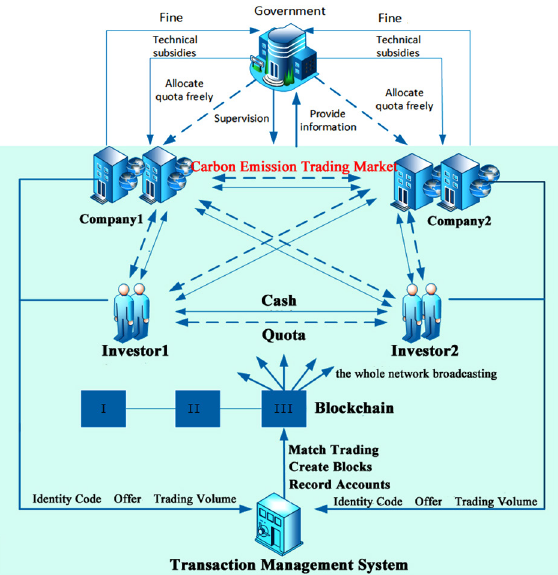
Figure 4. Transaction flow chart based on private